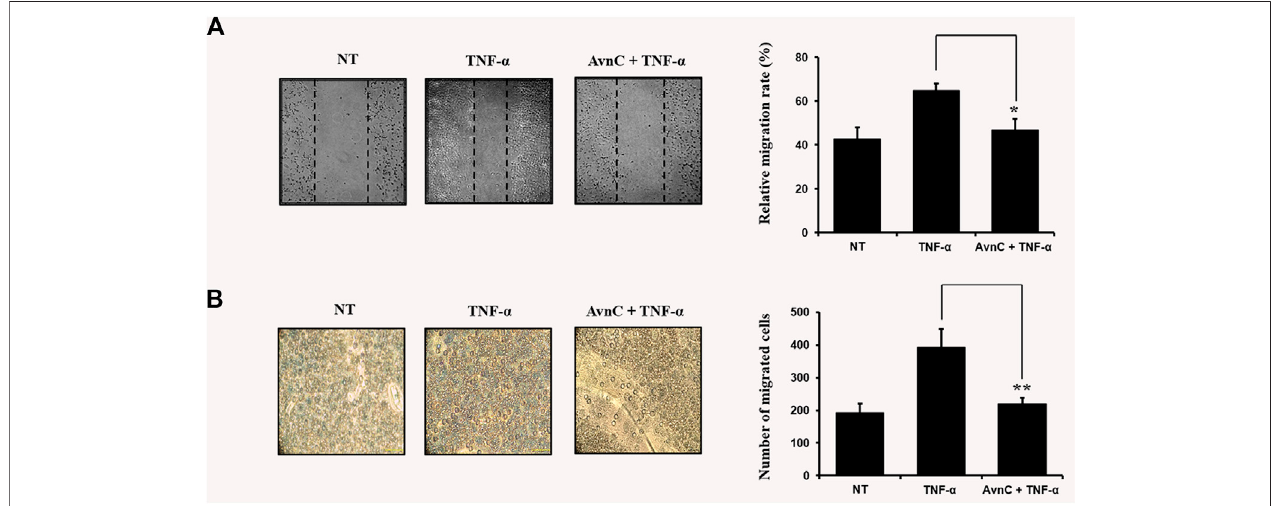
FIGURE2| AvnCinhibitsTNF- α -stimulatedmigrationandwoundhealingofHASMCcells (A) HASMCcellswerescratchedwithayellowpipettetip.Thecellswere treated with 100 ng/ml TNF- α with or without 100 μ M Avn C for 24 h. Cells migrated into the wound area (B) The migration ability of HASMC cells was detected by a transwell assay. The cells were incubated with 100 ng/ml TNF- α with or without 100 μ M Avn C for 24 h. Results shown are representative of three independent experiments. They are presented as mean ± SEM. * p < 0.05 and ** p < 0.01, signi fi cant differences from TNF- α treated cells. NT, no treatment.